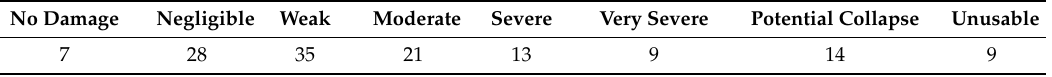
Table 3. Classification of the structures of Patigno a ff ected by landslide-induced